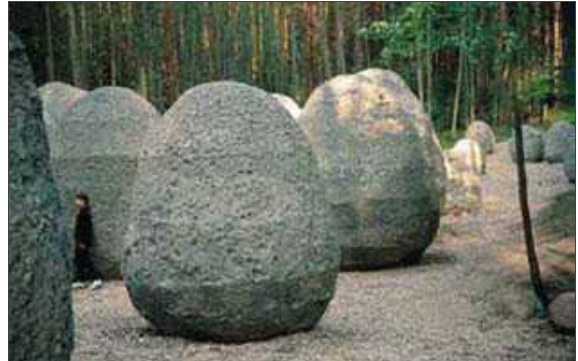
Fig. 6. Natural immediacy of the sculptural environment in the V. Orvidas’